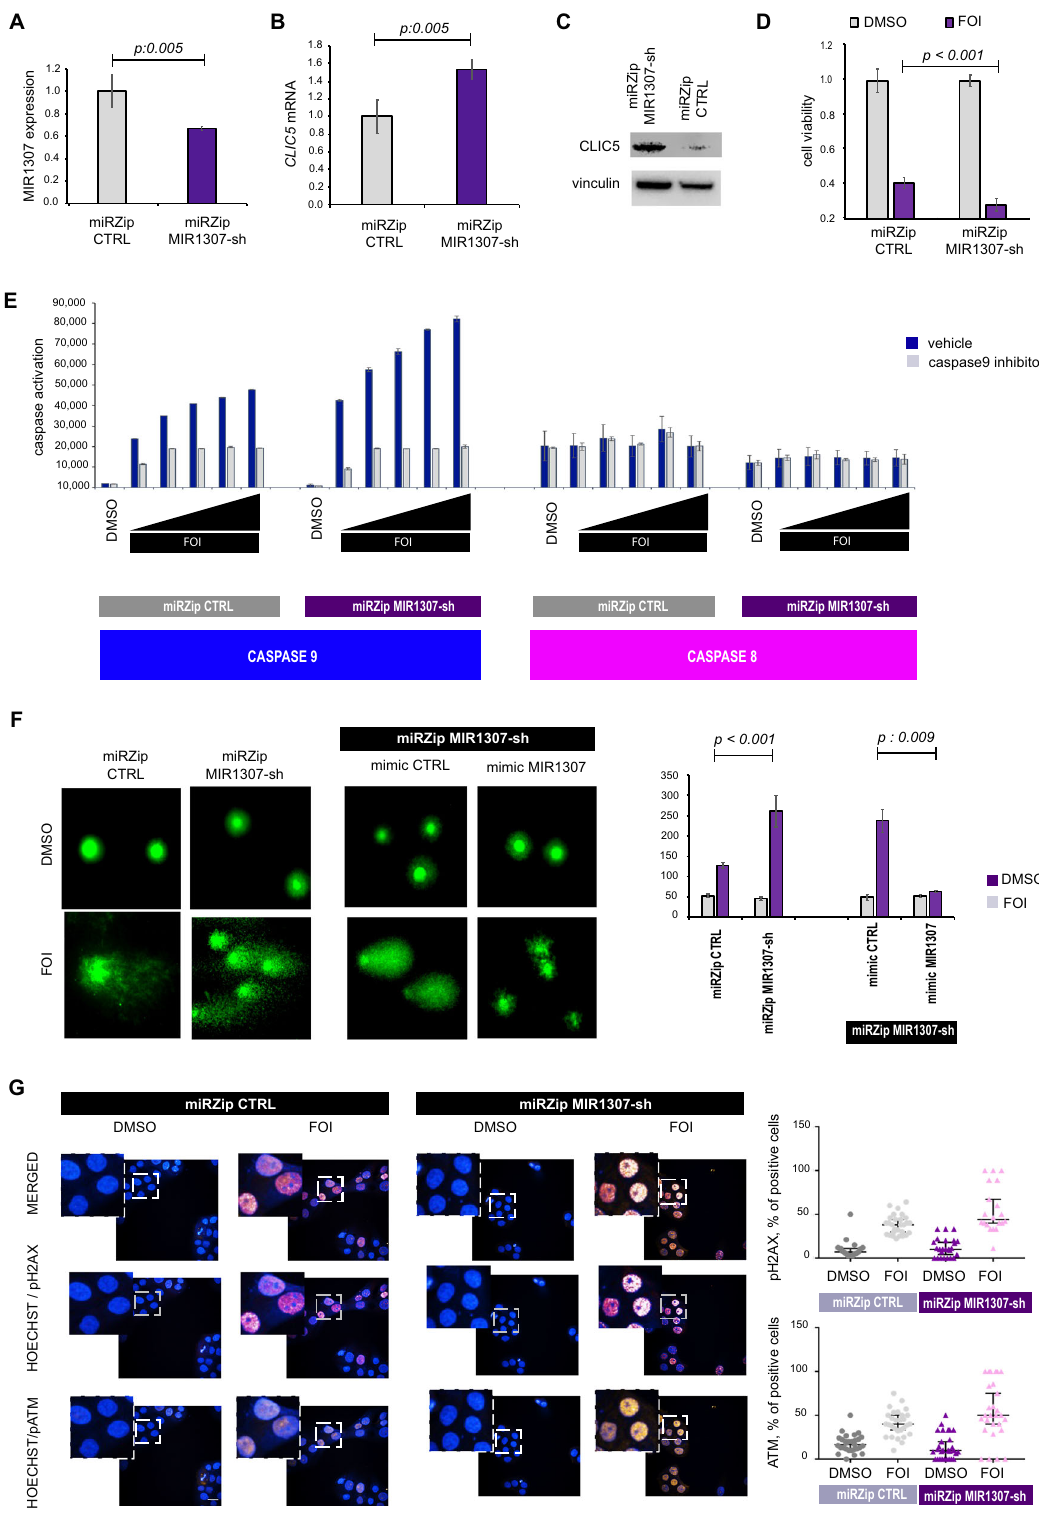
Cell viability . Cell viability was measured by CellTiter-Blue ® Assay (Promega, Madi- son, WI, USA) and the GI 50 derived using Prism Software (Graphpad, La Jolla, USA). High-throughput-screening (HTS) . A human LNA MIR inhibitor library (miR- CURY LNA, version 3) from Exiqon (Qiagen, UK) was purchased. The library was distributed across 5 × 384-well plates (Greiner Bio-One, Frickenhausen, Germany). Each plate included two negative controls (LNA negative A, LNA negative B from Exiqon; each in quadruplicate), a positive control in quadruplicate (siTOX from